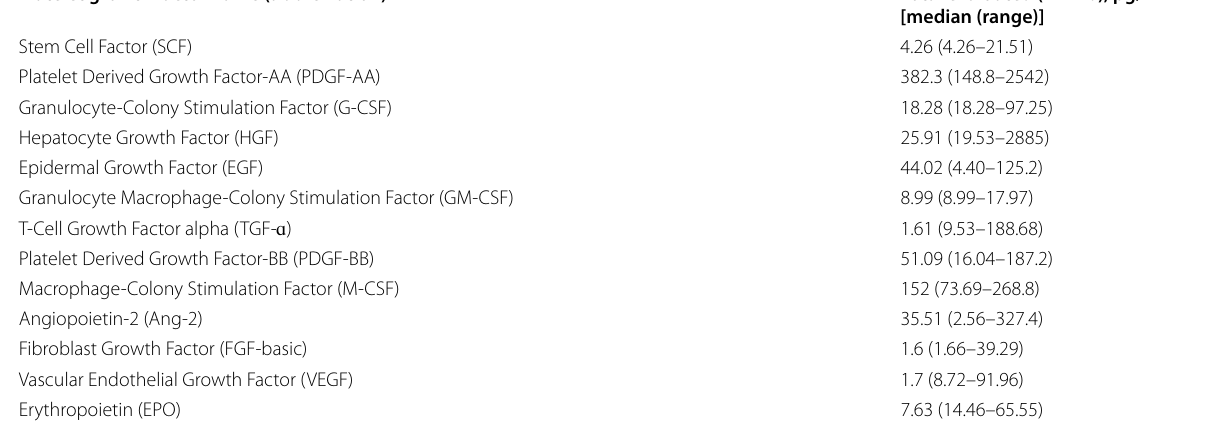
a : χ 2 ‑test; b : Mann‑Whitney test for non‑parametric samples; c : significant difference; d : highly significant difference; pg: picograms